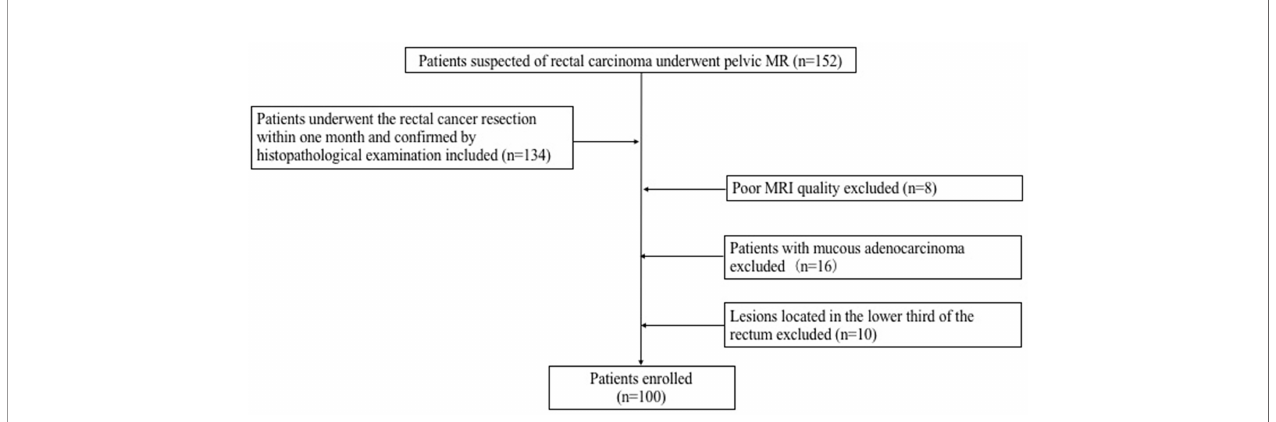
FIGURE 1 | Flowchart for